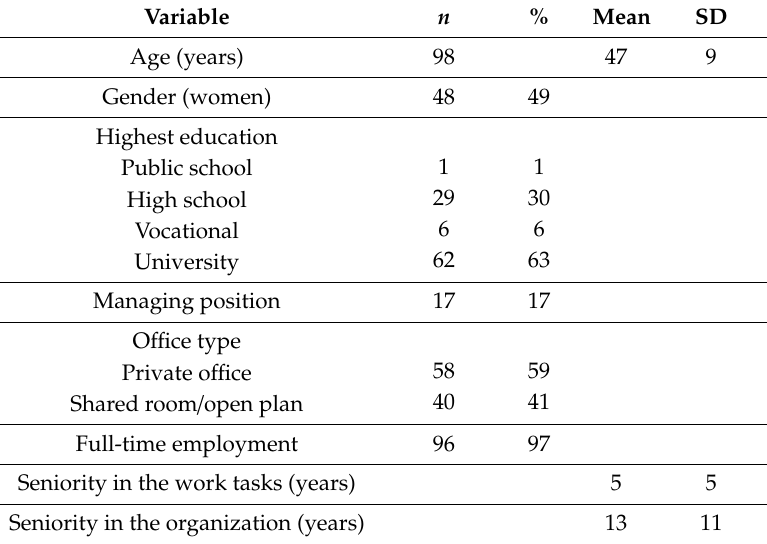
Table 1. Demographic information of the study sample at baseline ( n =